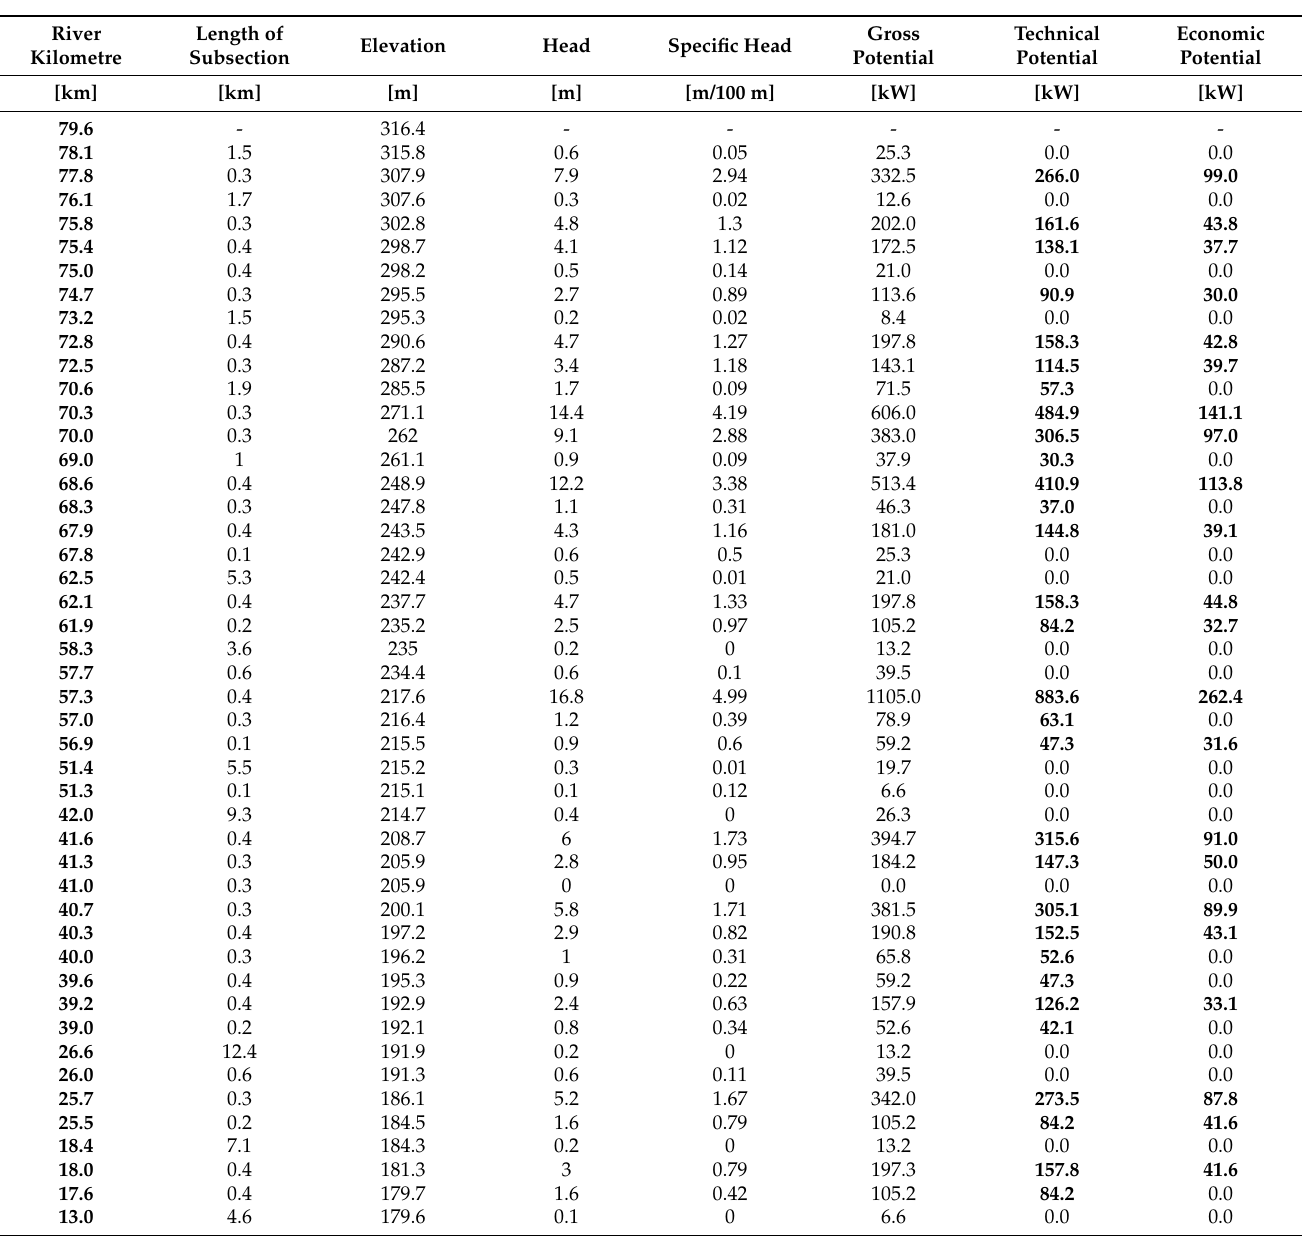
Table 6. Summary of gross (theoretical), technical, and economic hydropower